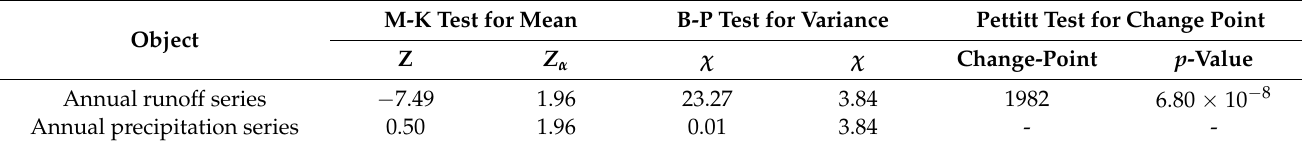
Table 1. The nonstationary tests of the annual runoff series in JRB.